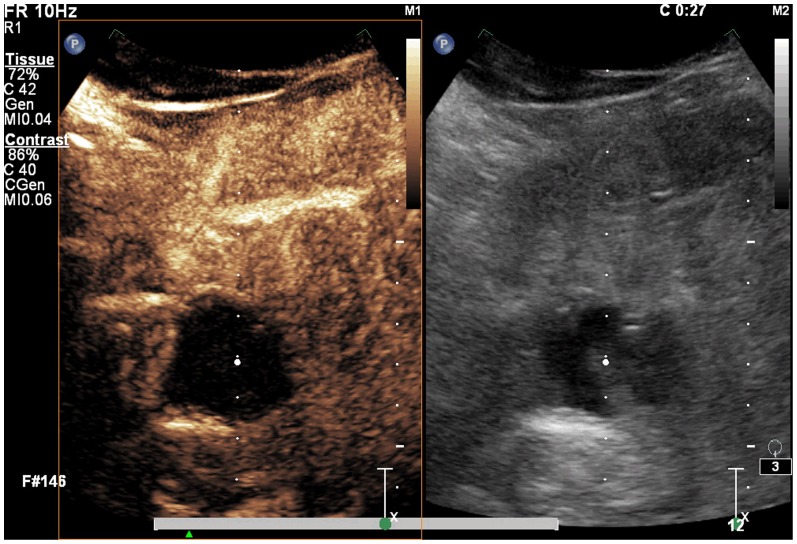
A spherical lesion with significantly decreased volume and no blood flow.Six months after treatment there is a significant decrease in the volume of the spherical lesion, with no reinforcement of its blood flow. There is no evident increase in blood flow of tissues surrounding the lesion.